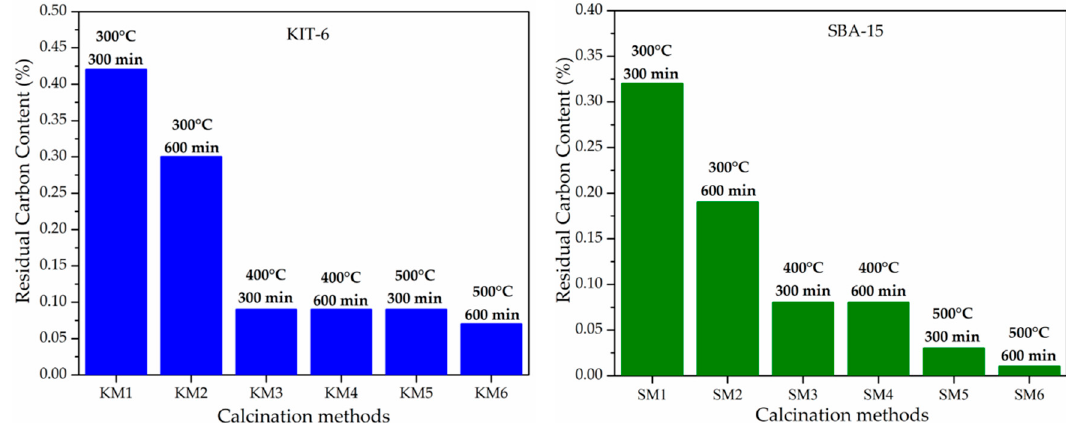
Figure 2. The residual carbon content for KIT-6 and SBA-15 after each calcination method.